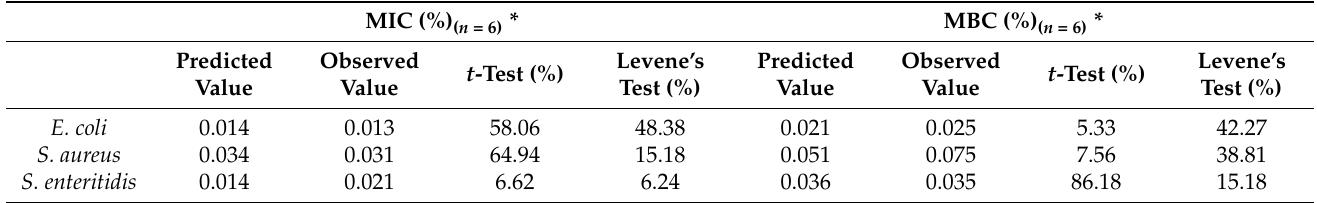
Figure 2. Desirability plot showing the optimal proportions of oregano (ORE; Origanum vulgare ), thyme (THY; Thymus vulgaris ), and lemongrass (LG; Cymbopogon citratus ) to the simultaneous inhibition (MIC) of Escherichia coli , Salmonella enterica serotype Enteritidis, and Staphylococcus aureus . Results are expressed in percentage (%) and are from twelve experiments, including three central replicates (Section 5.3). Table 3. Observed values and validation for the optimal mixture of oregano (ORE; Origanum vulgare ), thyme (THY; Thymus vulgaris ), and lemongrass (LG; Cymbopogon citratus ) essential oils (EOs) against Escherichia coli , Staphylococcus aureus , and Salmonella enterica serotype Enteritidis considering minimum inhibitory concentration (MIC) and minimum bactericidal concentration (MBC)